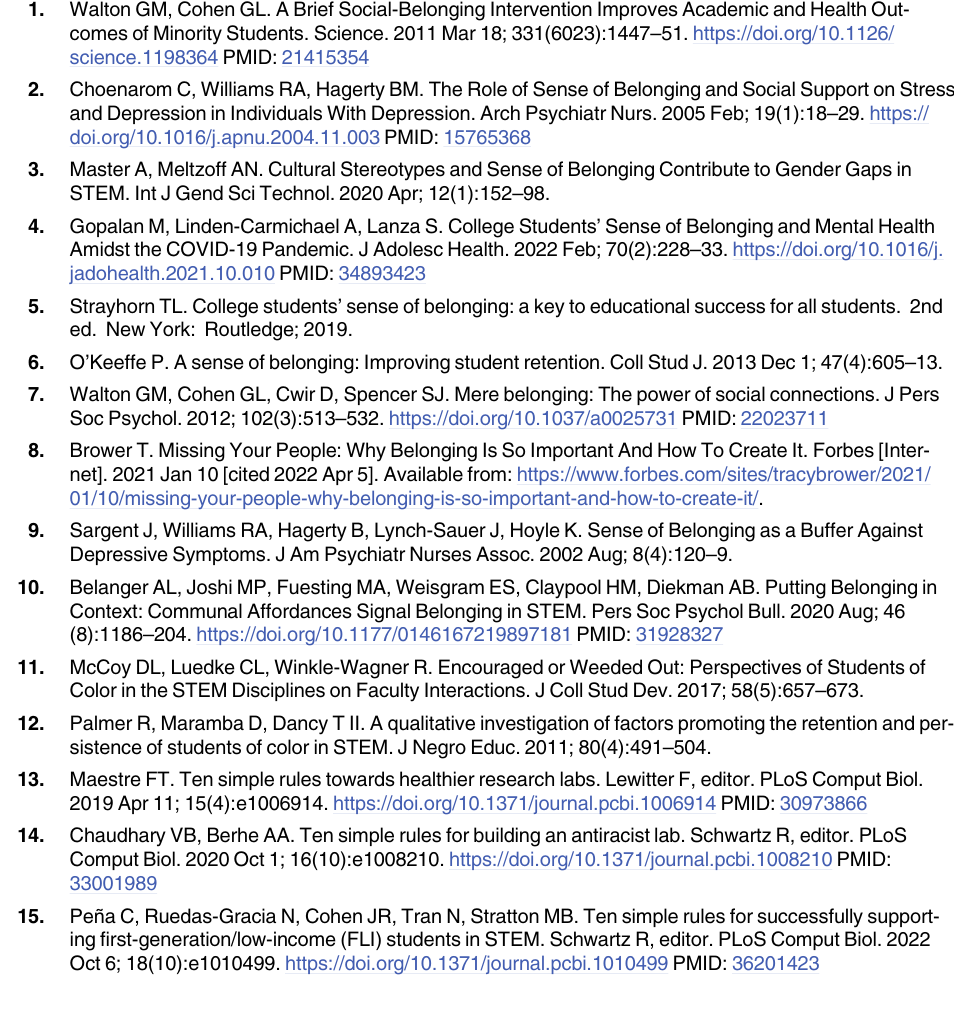
S1 Fig. Summary of rules to create a sense of belonging in your research group. (TIFF) S2 Fig. Glossary of terms: Ten simple rules for creating a sense of belonging in your research group.